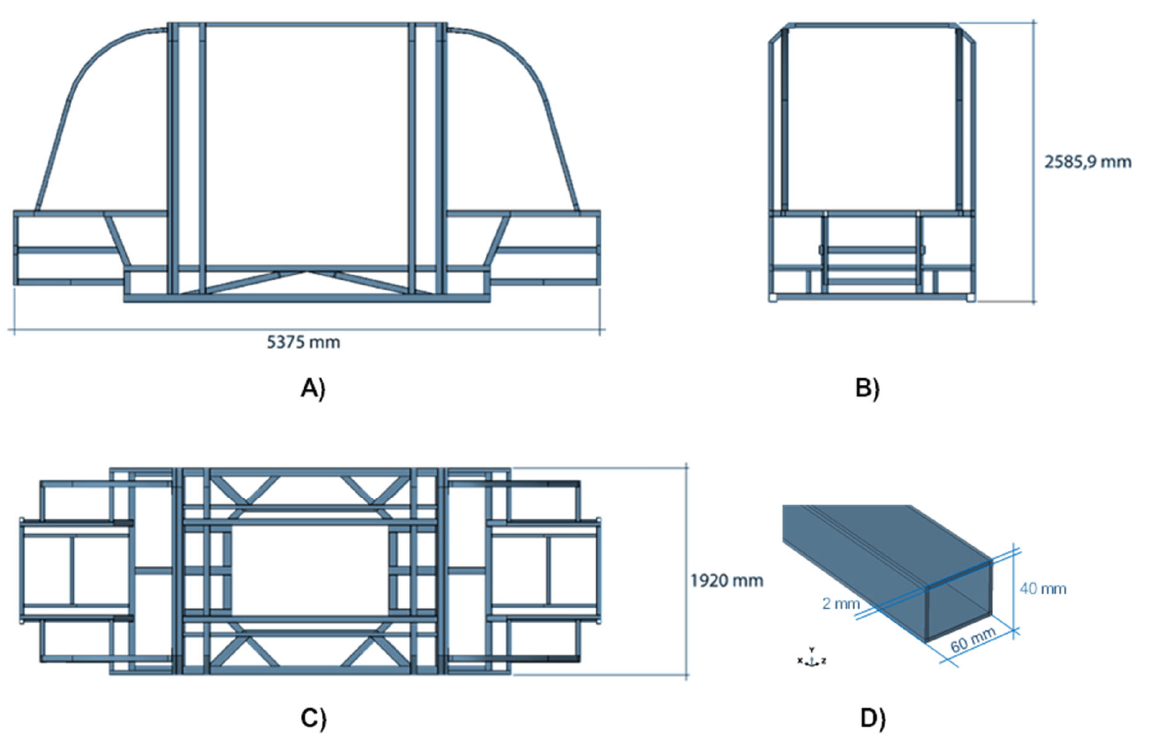
Figure 2. Geometrical dimensions of the chassis. ( A ) lateral view, ( B ) frontal view, ( C ) top view, and ( D ) detail of the frame component.